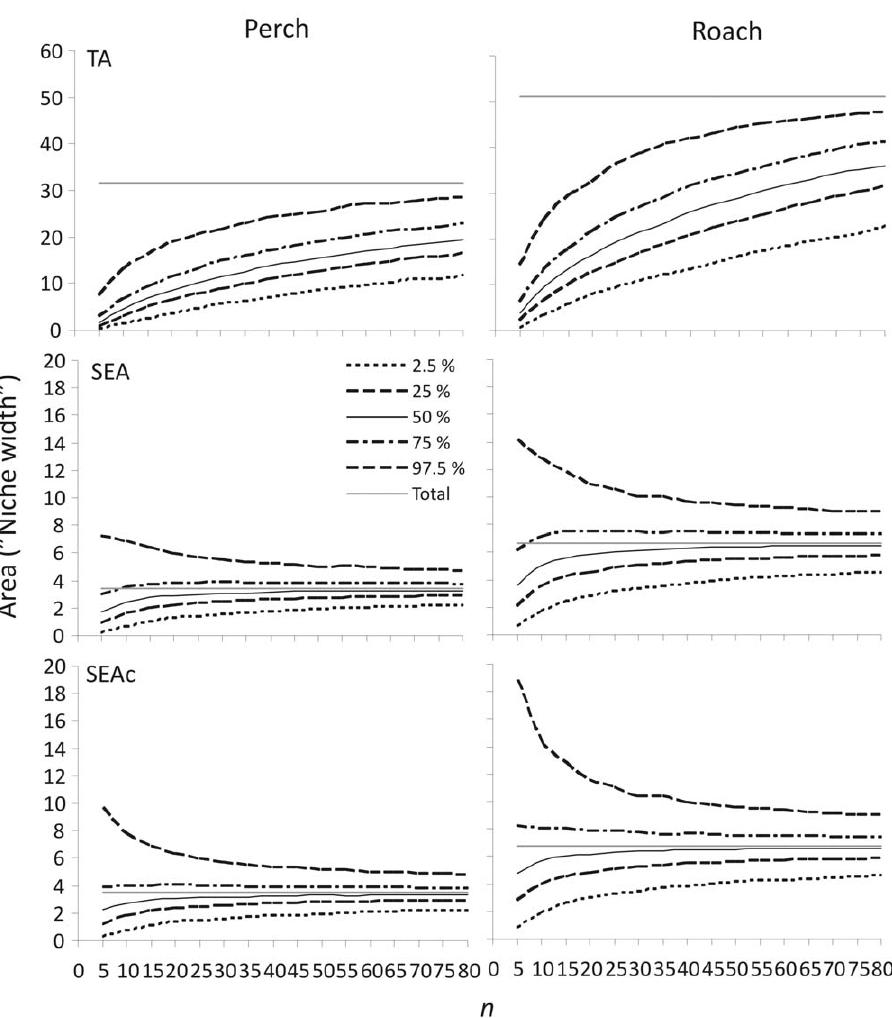
Figure 4. Population isotopic niche width modelling using increasing sample size. Perch (left panel) and roach (right panel) population datasets were used to estimate the convex hull TA, SEA and SEA c calculated for 5000 random selections of individuals with increasing sample size ( n + 5). Lines represent the upper 97.5%, 75%, 50% and lower 25% and 2.5% percentiles for the niche area estimates after each 5000 resamplings with increasing sample size. The solid grey line indicates the observed ‘‘true’’ total niche area for each metric ( n =202 for perch and n =173 for